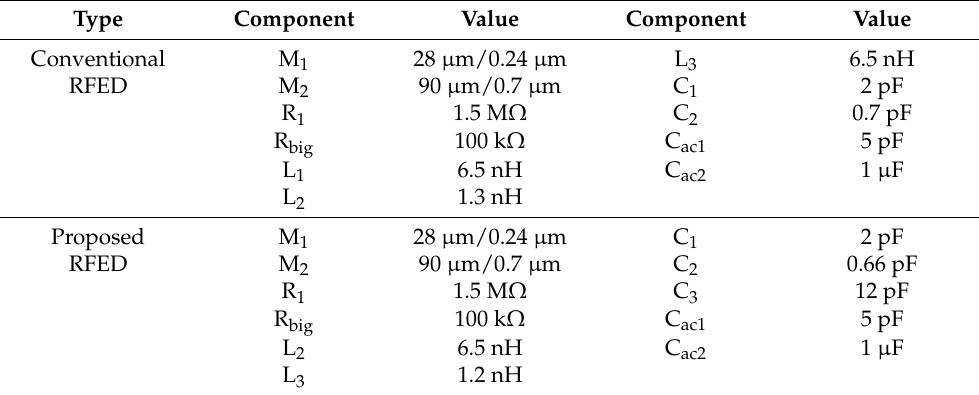
Figure 4. Simulated conversion gain of the conventional and proposed RFED. Table 1. Component values of the conventional and proposed RFED.